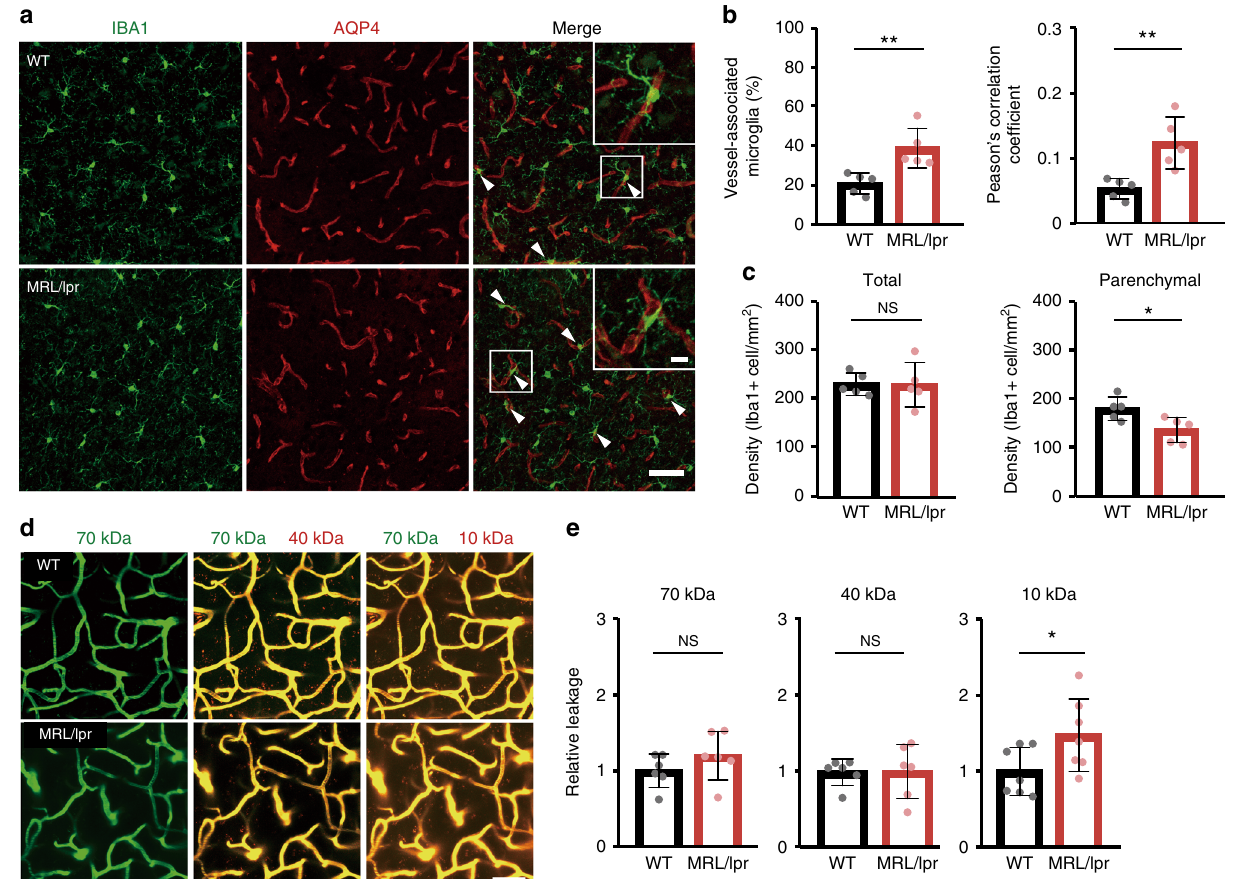
Fig. 1 Systemic in fl ammation is associated with a leaky BBB and a close association between microglia and cerebral blood vessels. a Fluorescent images of IBA1 (microglia, green) and AQP4 (astrocyte end-feet marker, red) in WT mice and in mice with chronic systemic in fl ammation (MRL/lpr mice). Upper right boxes in right panels show magni fi ed images of a typical blood vessel with associated microglia. Scale bar, 50 and 10 μ m for magni fi ed image. Arrowheads indicate a contact between microglia and blood vessels. b The proportion of microglia in contact with blood vessels and the extent of overlap of IBA1 and AQP4 fl uorescence as quanti fi ed by a Pearson ’ s correlation coef fi cient were both higher in MRL/lpr mice than in WT mice. c The density of parenchymal microglia (right panel) is decreased in MRL/lpr mice, whereas the total density of microglia in the whole fi eld of view (left panel) is the same in WT and MRL/lpr mice. d , e BBB permeability was quanti fi ed from the leaking of different molecular size (10, 40, 70 kDa) dextran-conjugated fl uorophores into the parenchymal space outside the vessels, with each dextran fl uorescing at a different color (and pseudo-colored here as green or red). Vessels were identi fi ed by the impermeant 70 kDa fl uorophore (green), while leak identi fi ed by leakage (red) of fl uorescence outside the co-labeled (yellow) vessels. Representative images (left) indicate that blood vessels in WT mice were impermeant to all these fl uorophores and only the blood vessels themselves fl uoresce (upper panels). Vessels in MRL/lpr mice are permeant to the 10 kDa dextran, which is visible in the parenchymal space adjacent to, and outside, the vessels (lower panels). Relative leakage is quanti fi ed by comparing mean parenchymal fl uorescence intensity in MRL/lpr mice with that in WT mice (normalized to 1.0). In MRL/lpr mice, vessels leak only the smaller 10 kDa dextran. Scale bars in d , 50 μ m. Graphs show data from an individual animal ( b , c , e ), overlaid with mean ± SD. NS not signi fi cant. * P < 0.05 and ** P <